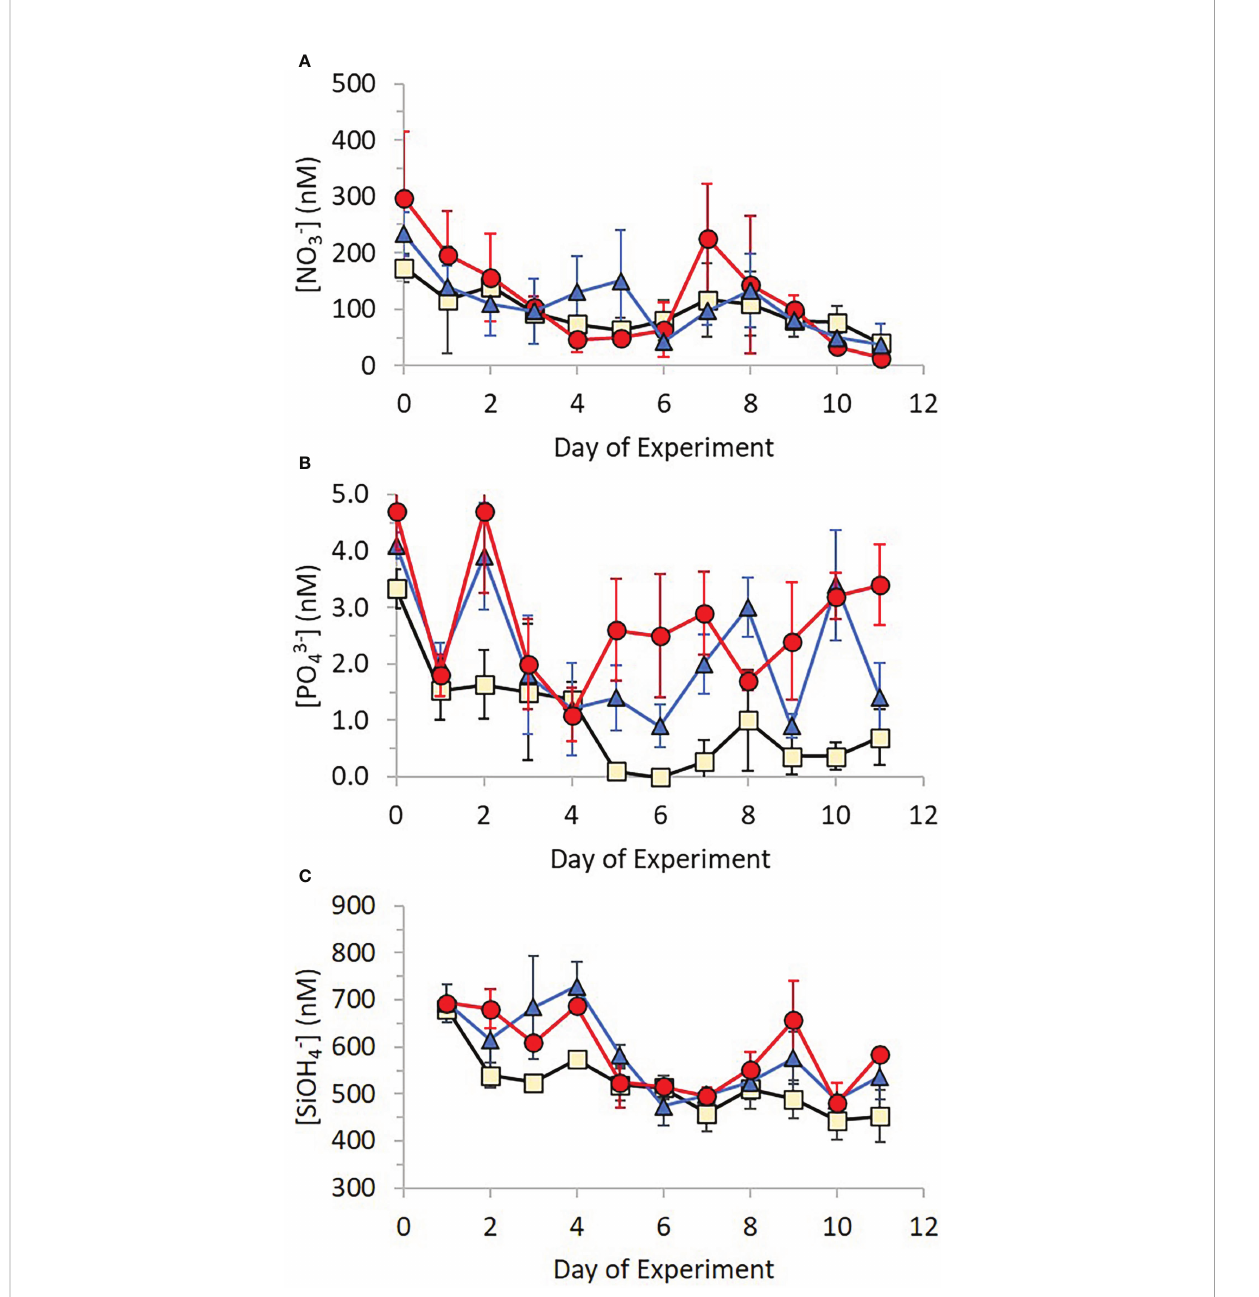
FIGURE 4 Changes in concentration of (A) nitrate, (B) phosphate and (C) silicate over time for each treatment (Control – beige; +Ag + – blue; +AgNP – red). Error bars show ± 1 standard deviation of the